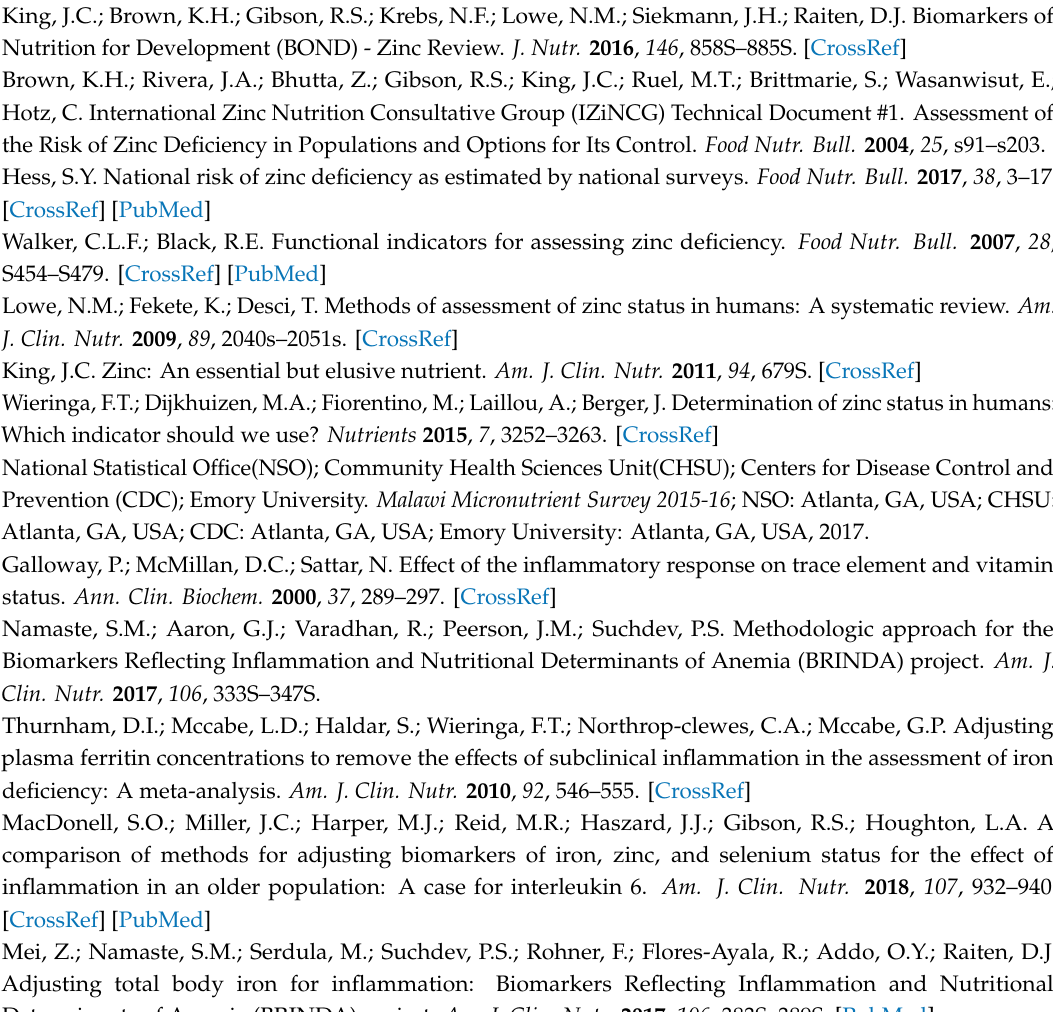
Table S1, Prevalence estimates of serum zinc deficiency and inflammation in Malawi, stratified by region, domicile type and gender, Figure S1, Bland-Altman regression plot for sensitivity analysis of di ff erences against means of ICF and